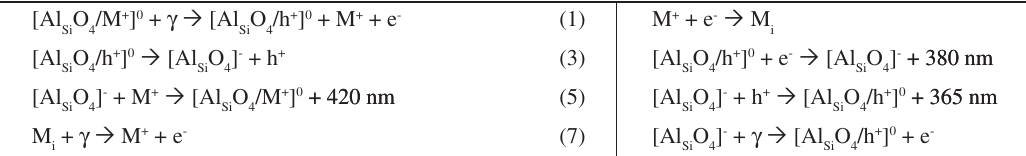
Table 1. Reactions during irradiation of quartz 2 .